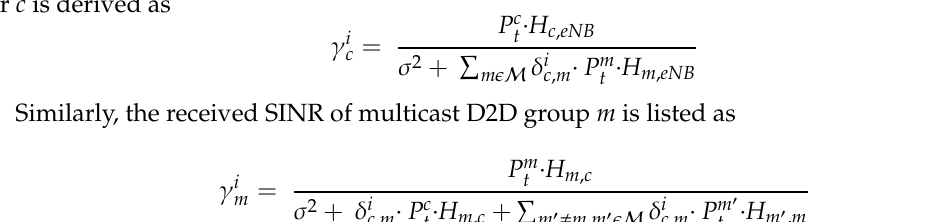
Figure 2. ( a ) System model for multicast device-to-device (D2D) communications, and ( b ) uplink interference scenarios.